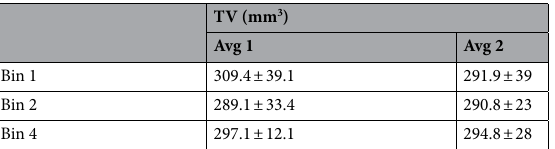
Table 1. Mean and standard deviation of TV values, according to frame averaging (Avg 1 or Avg 2) and data binning (Bin 1, Bin2, and Bin 4).